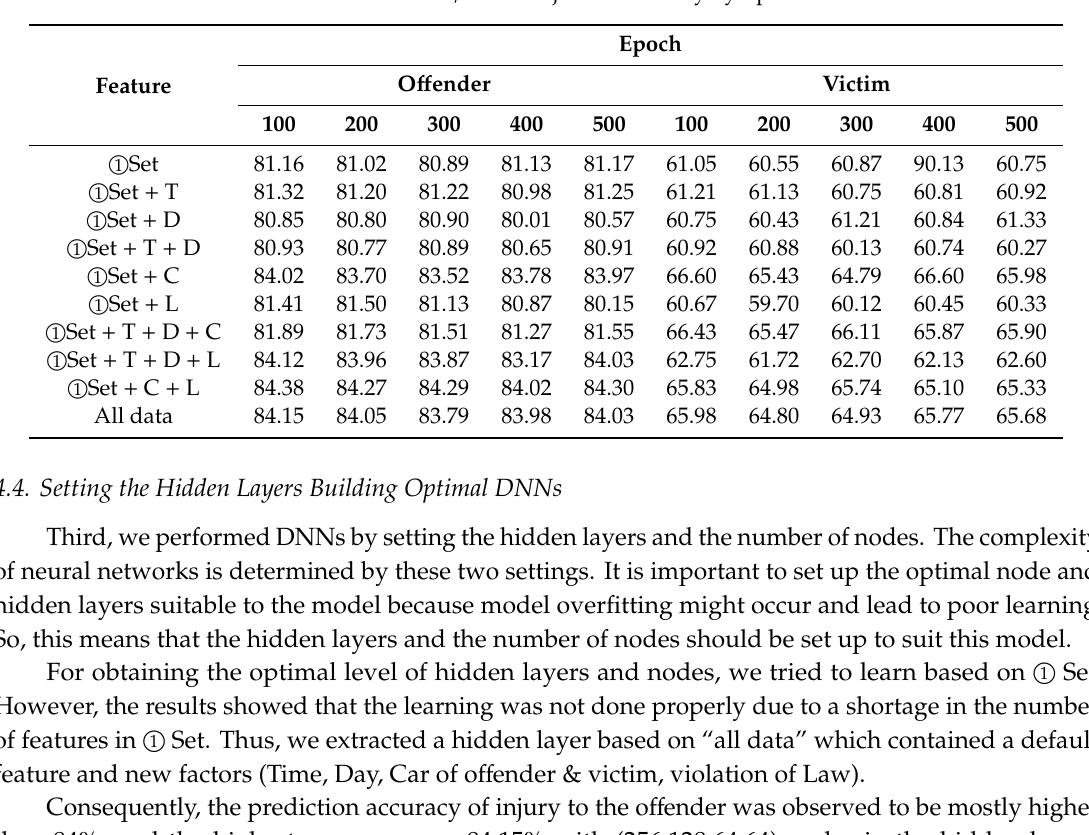
Table 5. O ff ender / Victim Injuries Accuracy by Epoch.